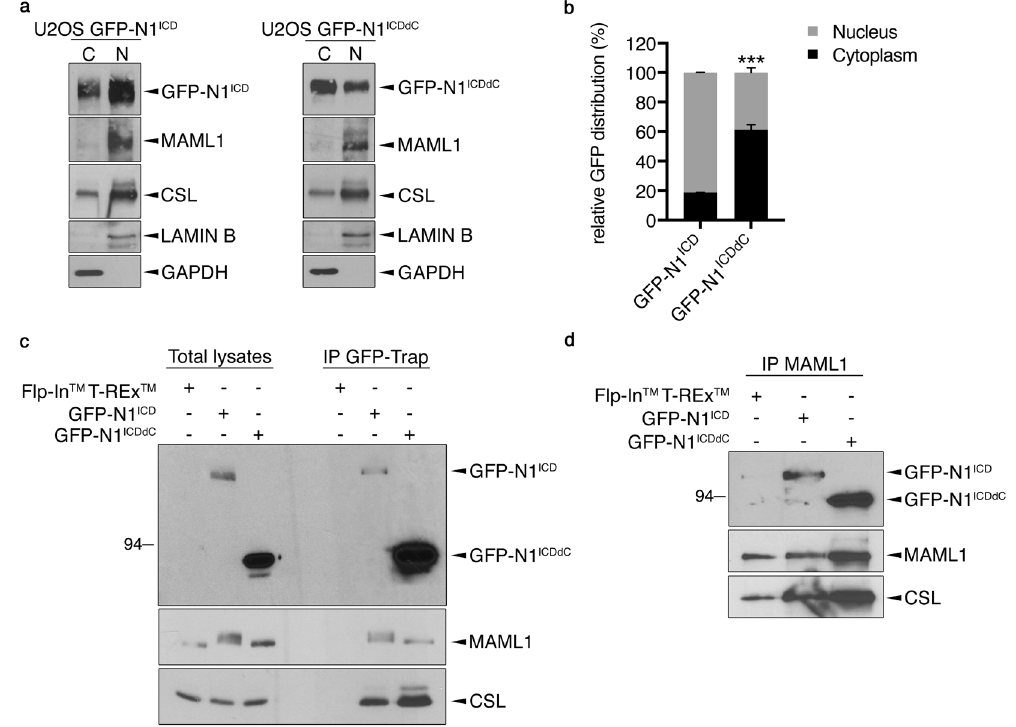
Figure 4. N1 ICDdC maintains its ability to interact with CSL and MAML1. ( a ) U2OS GFP-N1 ICD and GFP- N1 ICDdC cell populations were induced with doxycycline for 24 h. Cytosolic and nuclear proteins were fractionated and immunoblotting analyses were performed using the specified antibodies. GFP-N1 ICD and GFP-N1 ICDdC expression levels were analysed using an anti-GFP antibody. Cropped blots are displayed and full- length blots are included in Supplementary Information. ( b ) A graphical representation of the mean distribution of GFP between cytosolic and nuclear compartment ± SEM of 3 independent experiments. Representative immunoblots were shown in a. *** p < 0.001 as compared with GFP distribution in U2OS GFP-N1 ICD cells. ( c ) The parental U2OS Flp-In TM T-REx TM , stable U2OS GFP-N1 ICD and GFP-N1 ICDdC cell populations were treated for 24 h with doxycycline. Total cell lysates were subjected to immunoprecipitation using GFP-Trap agarose beads (IP GFP-Trap) and analysed for N1 ICD and N1 ICDdC expression (using GFP antibody) as well as MAML1 and CSL. Cropped blots are displayed and full-length blots are included in Supplementary Information. ( d ) The parental U2OS Flp-In TM T-REx TM , stable U2OS GFP-N1 ICD and GFP-N1 ICDdC cell populations were treated for 24 h with doxycycline. Total cell lysates were subjected to immunoprecipitation using an anti-MAML1 antibody (IP MAML1) and analysed for N1 ICD and N1 ICDdC expression (using GFP antibody) as well as MAML1 and CSL. Cropped blots are displayed and full-length blots are included in Supplementary